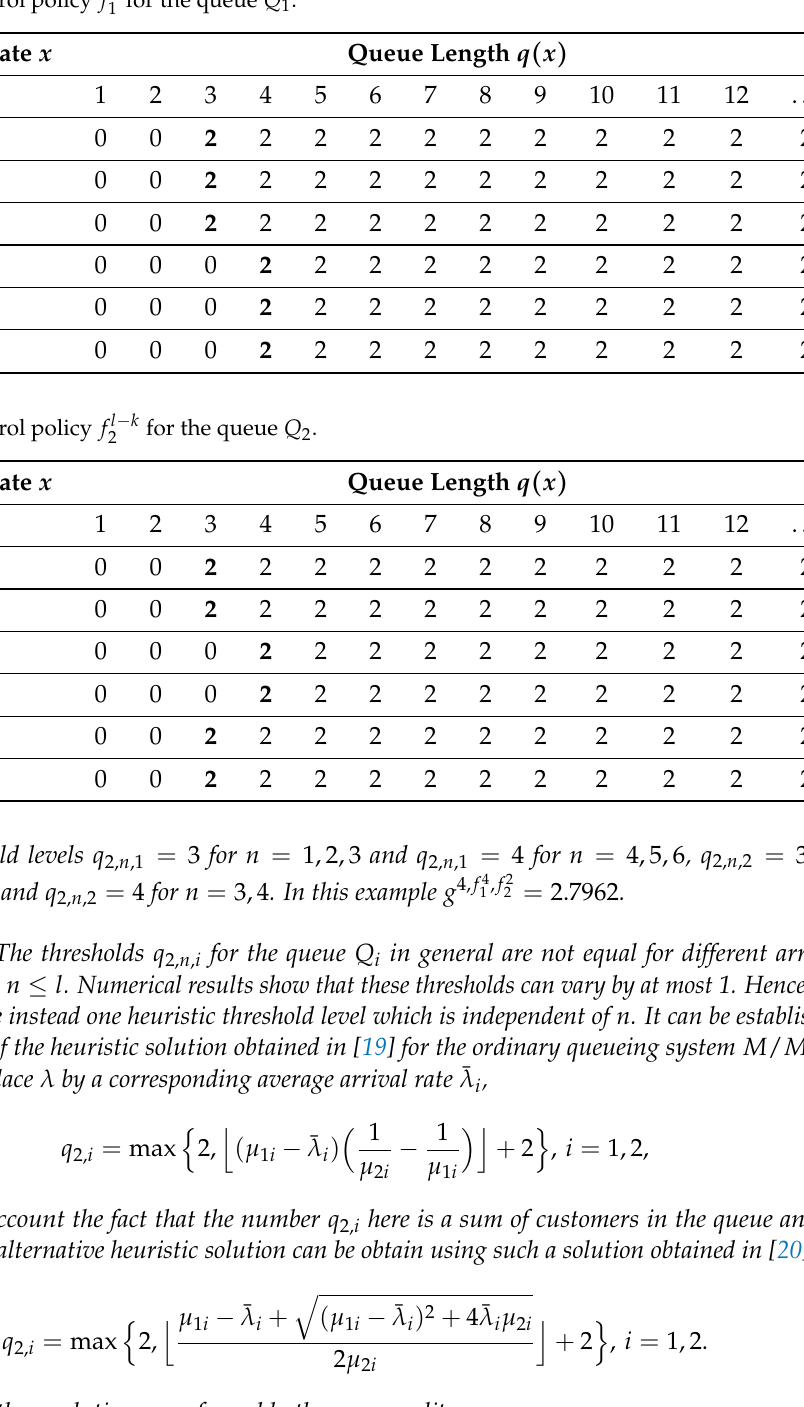
Table 1. Control policy f k